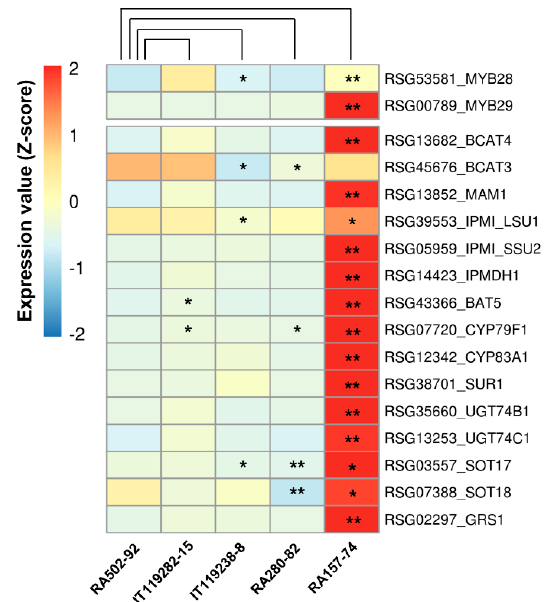
Figure 7. Analysis of DEGs involved in the GRH biosynthesis in radish roots. Expression values (FPKM) of individual genes were normalized by Z-score and scaled per row (i.e., per gene) for the visualization of the expression peaks of genes among the accessions. Significant differences are indicated as * p < 0.05 and ** p < 0.01 (Student’s t test).